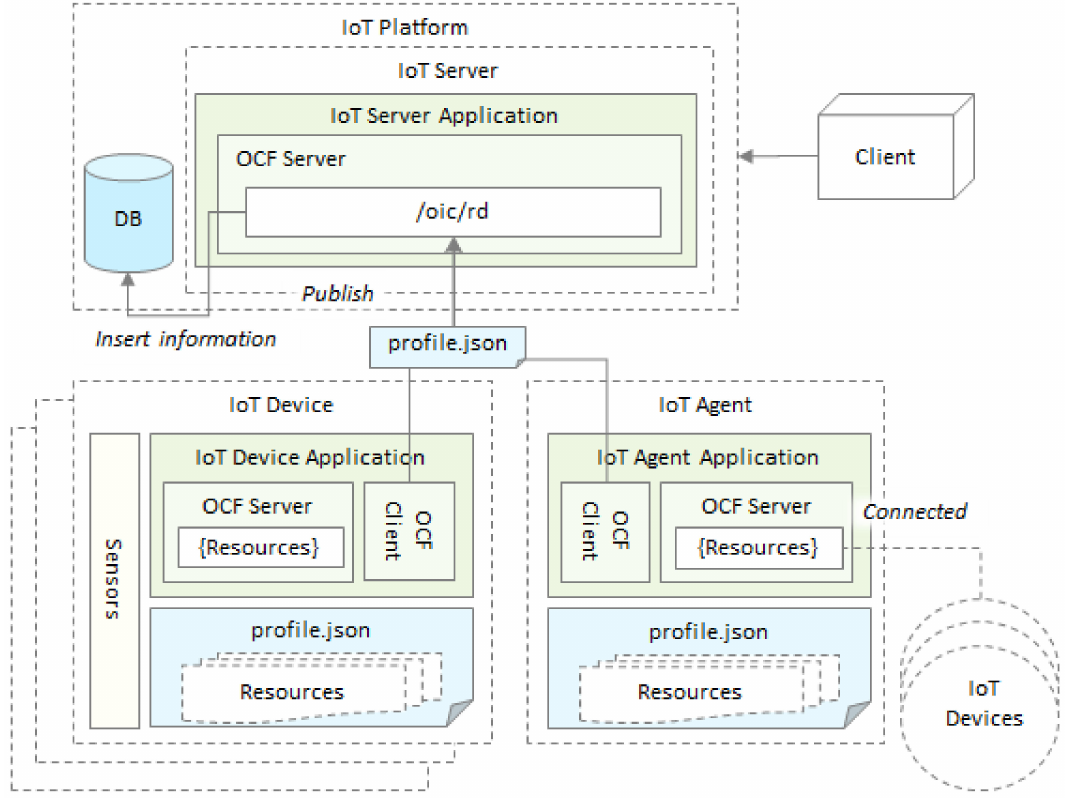
Figure 3. IoT configuration based on self-registration through an Open Connectivity Foundation (OCF)